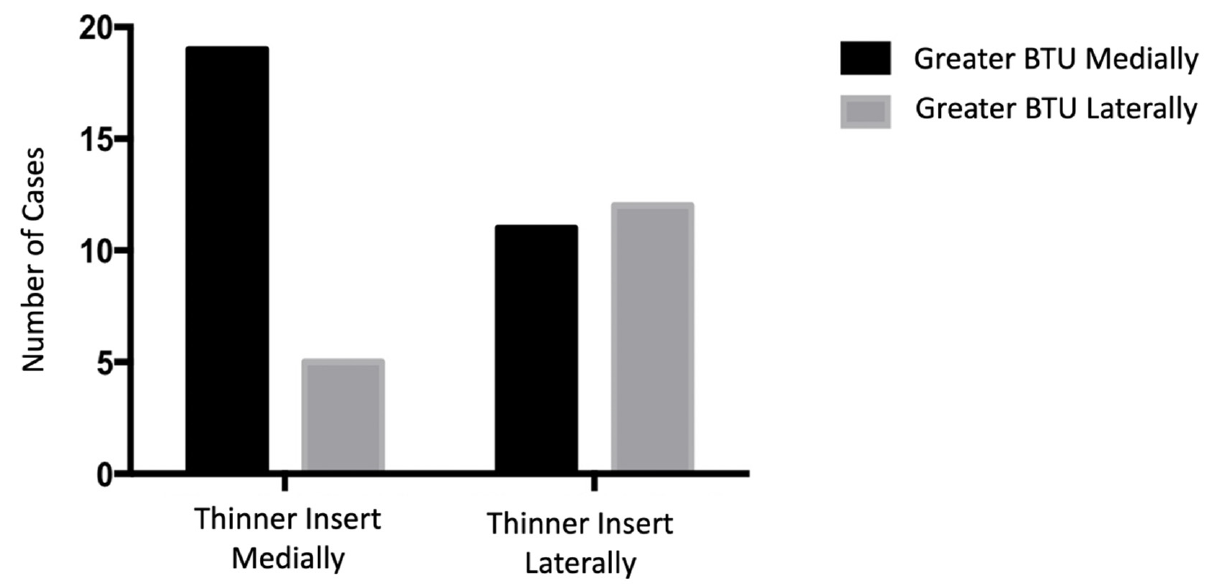
Figure 4. Graph showing the correlation between micro-CT and SPECT/CT data: a more extended BTU on the medial compartment (black boxes) was significantly correlated with a thinner insert in the medial compartment; whilst a more extended BTU on the lateral side (grey boxes) was significantly associated with a thinner insert in the lateral compartment.